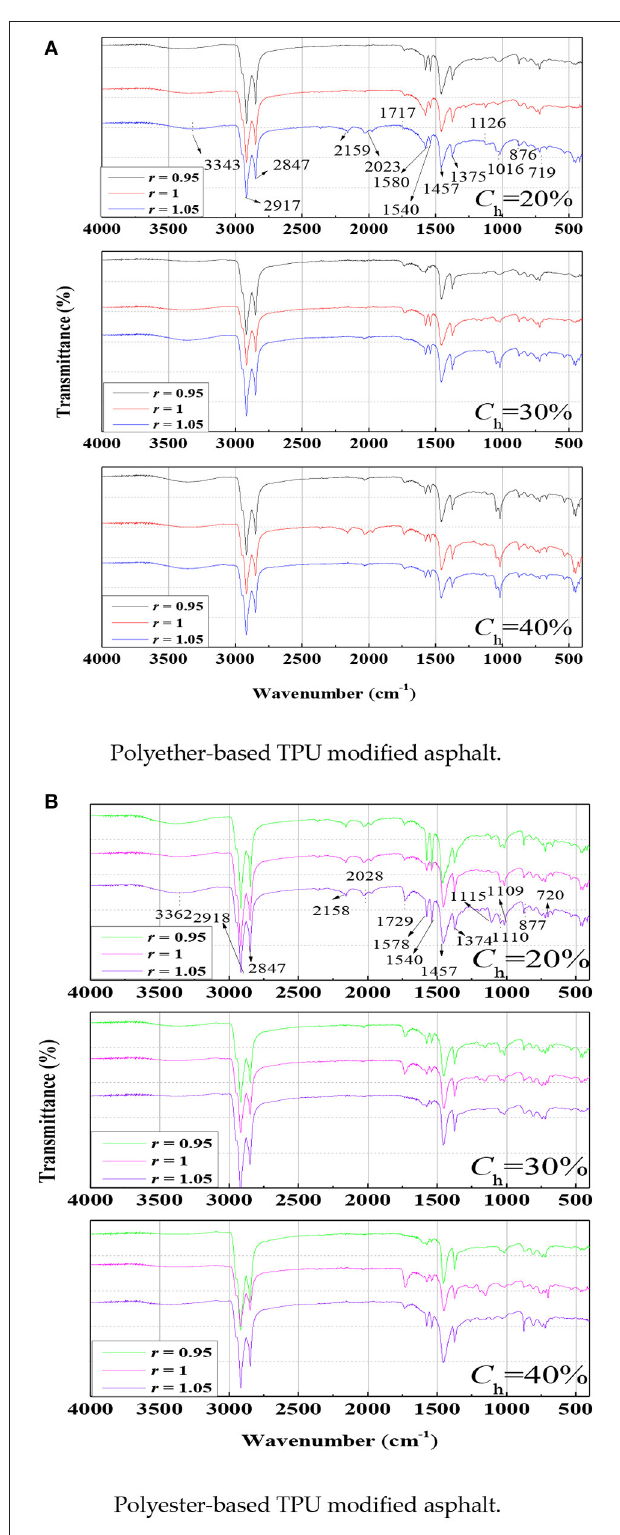
FIGURE 17 | FTIR of different modified asphalt. (A) Polyether-based TPU-modified asphalt. (B) Polyester-based TPU-modified